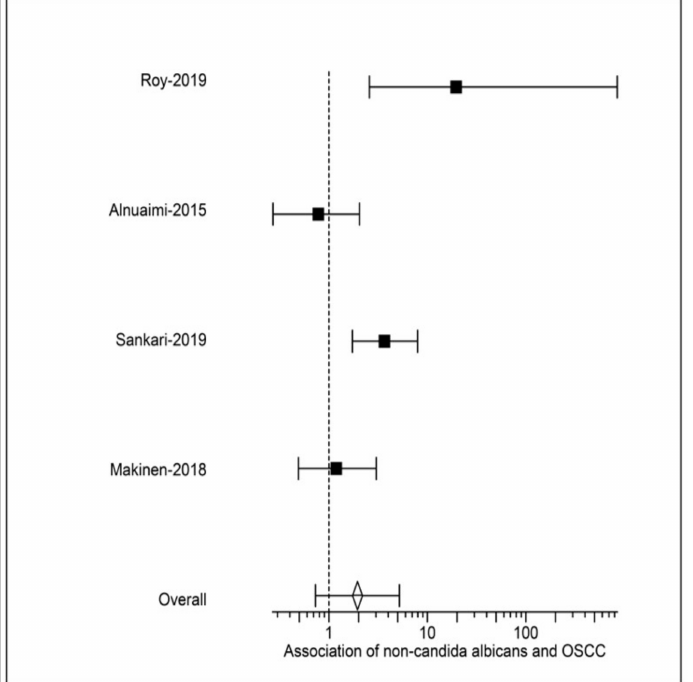
Figure 4. Forest plot summarizing the results of the meta-analysis for NCA and